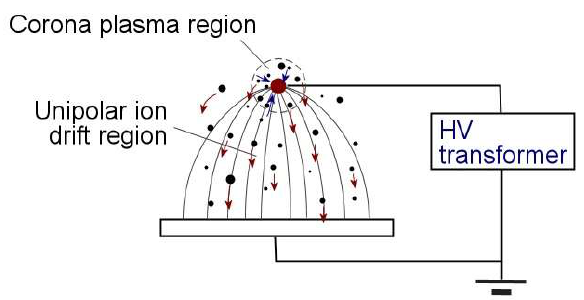
Figure 4. Schematic of the generation of ionic wind by corona discharge.